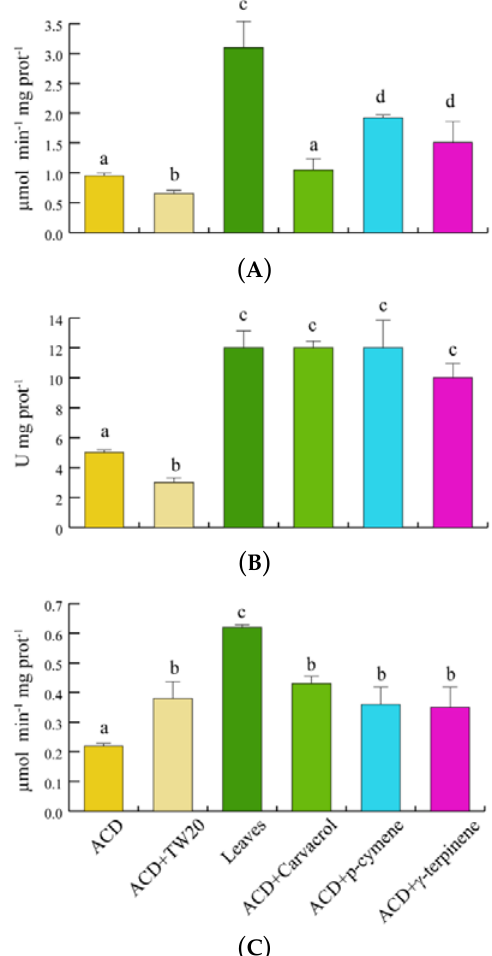
Figure 6. Antioxidant enzymes activities of S. littoralis after feeding on O. vulgare leaves and terpenoids. ( A ). Catalase (CAT) activity. ( B ). Superoxide dismutase (SOD) activity. ( C ). Glutathione S -transferase (GST) activity. Values are the mean of at least three replicates; metric bars indicate standard deviation. Different letters indicate significant ( p < 0.05)